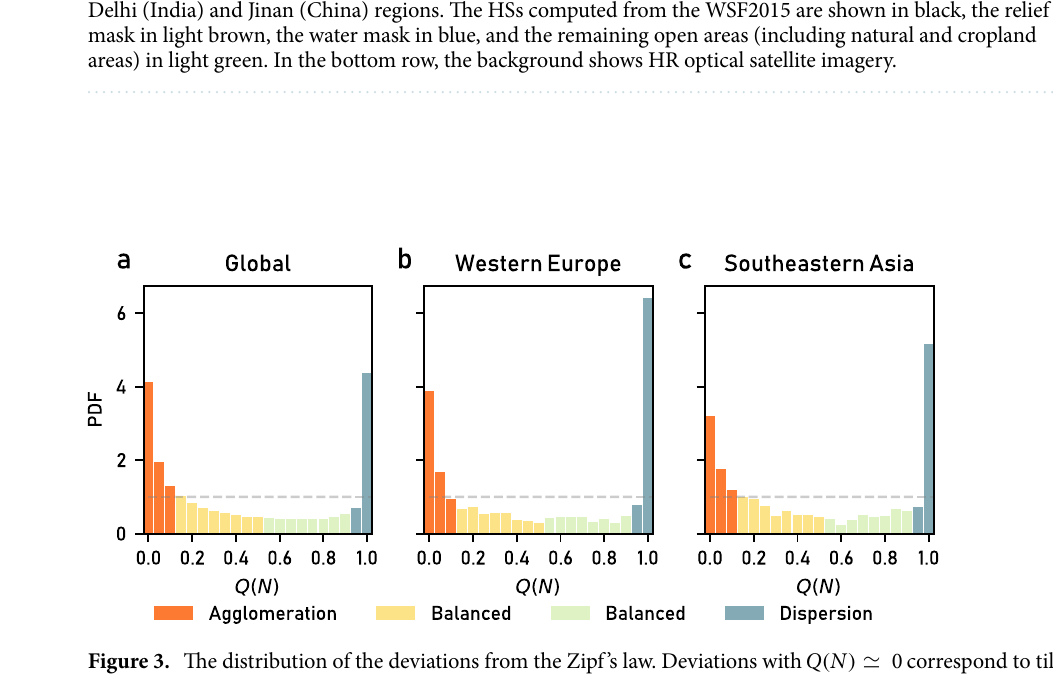
Figure 3. The distribution of the deviations from the Zipf’s law. Deviations with Q ( N ) ≃ 0 correspond to tiles with a smaller number of HSs than expected, while when Q ( N ) ≃ 1 tiles have a higher number of HSs than expected by the theoretical model. We observe two peaks in all the macroareas. ( a ) The global distribution; ( b , c ) two examples of distributions within a macroarea. The colors indicate our proposed